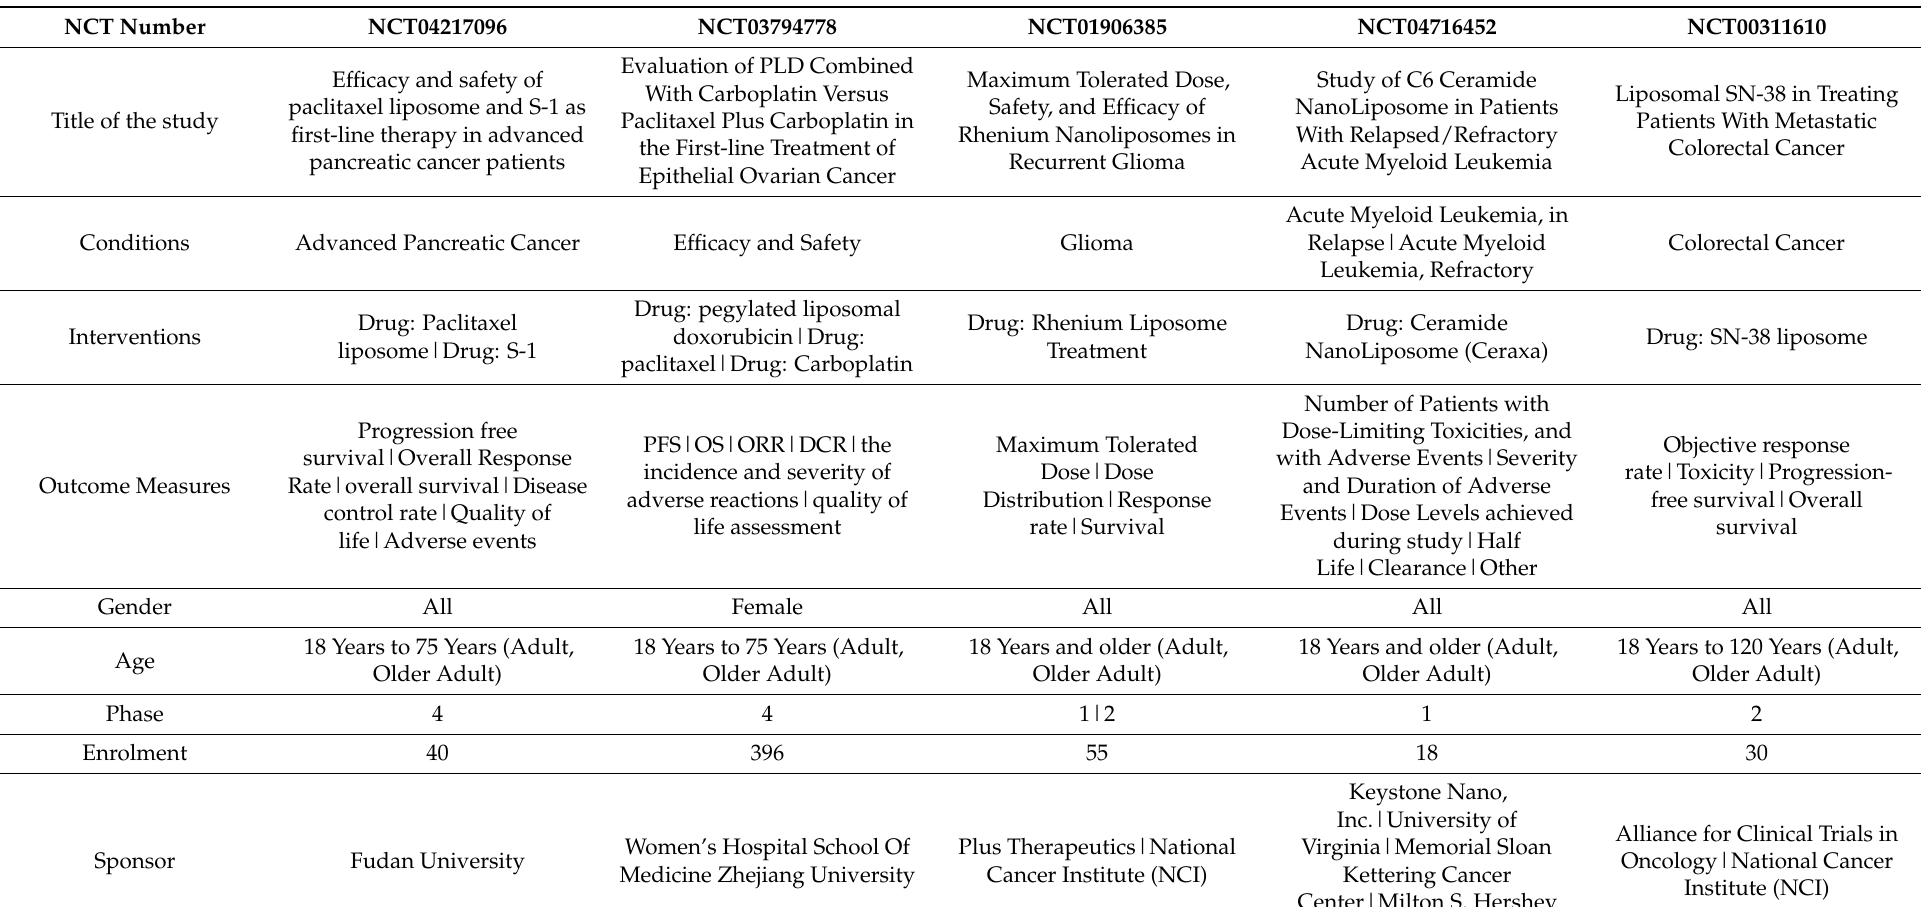
Table 2. Liposome-based products in clinical trials for cancer